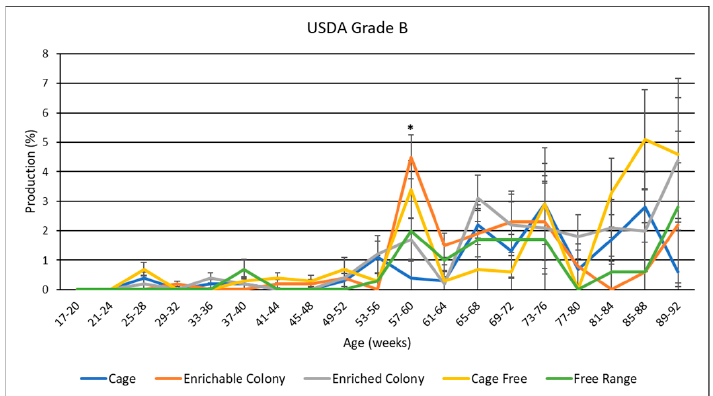
Figure 7. The effect of housing system on USDA grade B egg production of brown egg layers by age. * Signifies a significant effect ( p < 0.05) of housing environment by age range on USDA grade B percentage.